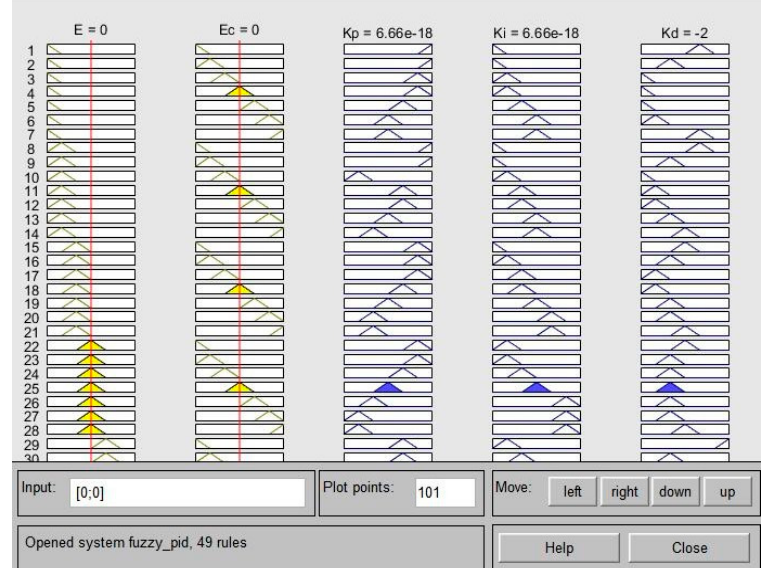
Figure 8. Fuzzy rule editor.